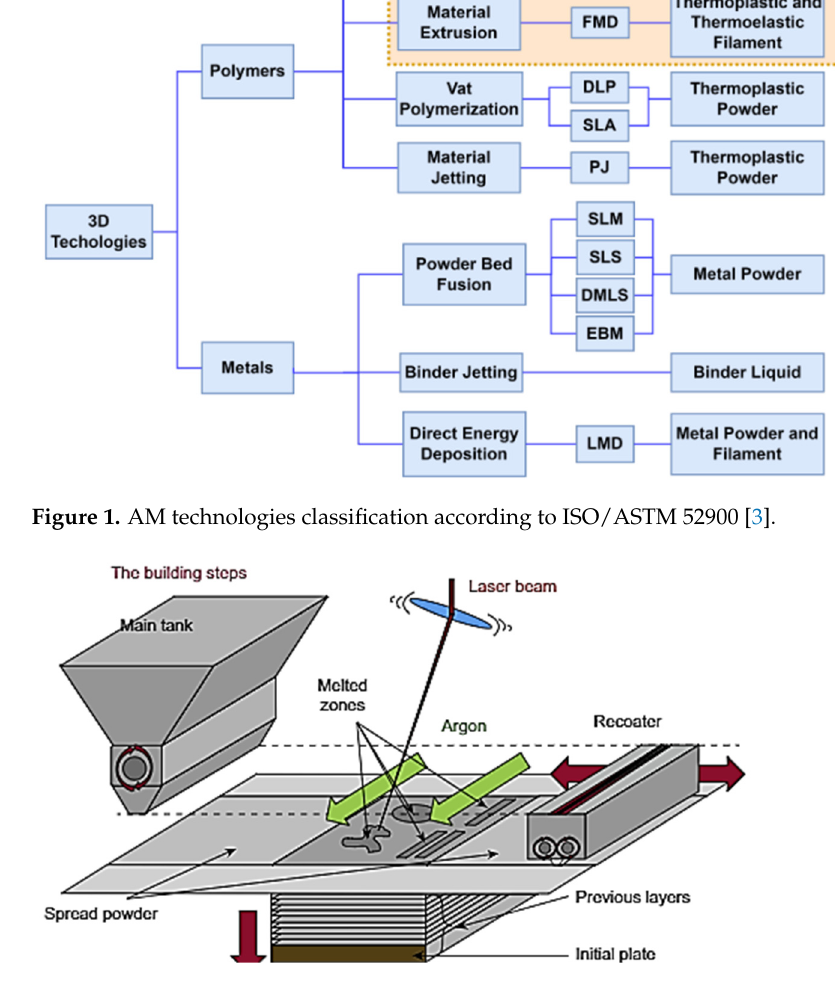
Figure 2. Elements of powder bed fusion process [13].